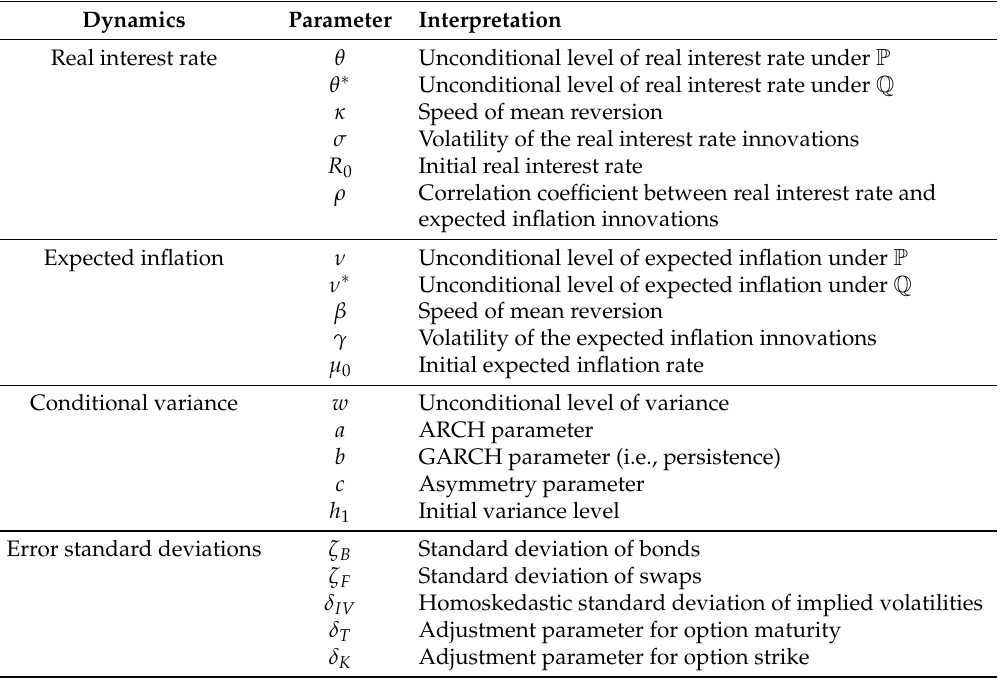
Table 1. Summary of the model parameters and their